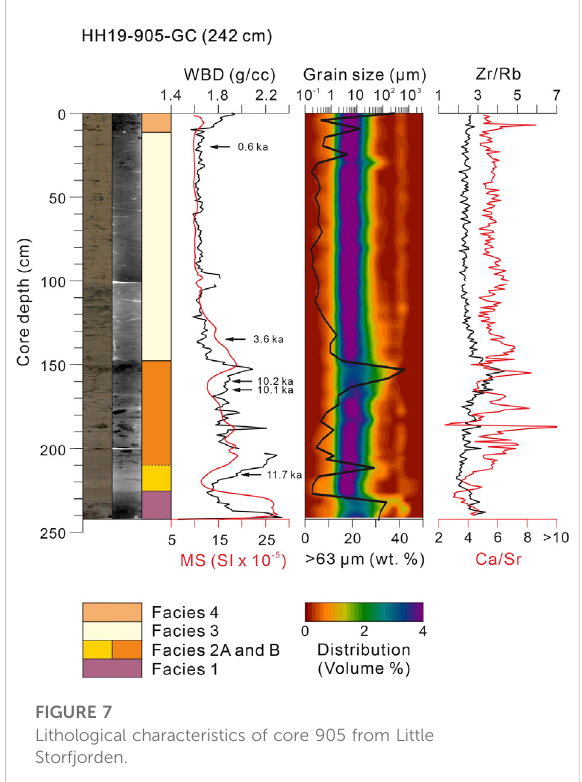
FIGURE 7 Lithological characteristics of core 905 from Little